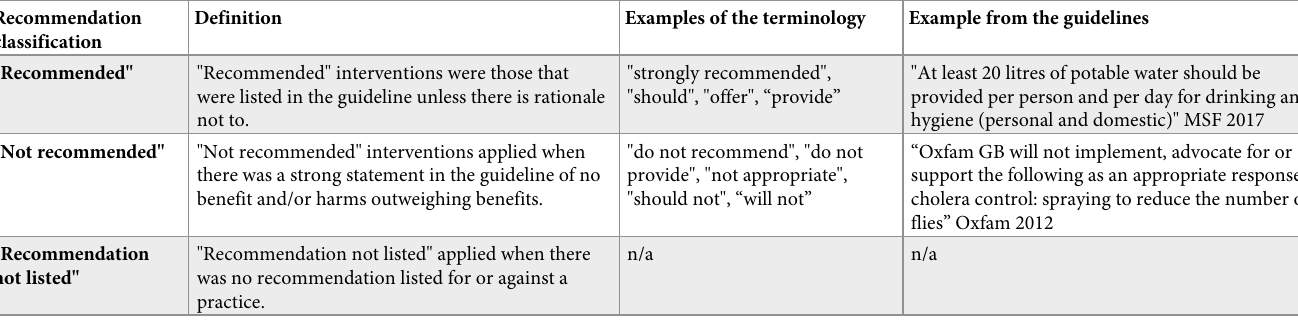
Table 2. Classifying recommendations, definitions and